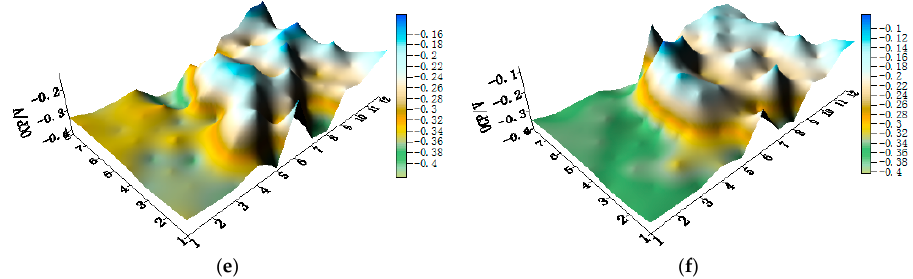
Figure 3. Open circuit potential (OCP) (vs. saturated calomel electrode (SCE)/V) distribution maps of the CMEA1 (HAl77-2/316L SS/TA2) after immersion in artificial seawater with different concentrations of chloride ions (wt %): ( a ) 1.5%; ( b ) 1.7%; ( c ) 1.9%; ( d ) 2.1%; ( e ) 2.3%; and ( f ) 2.5%.